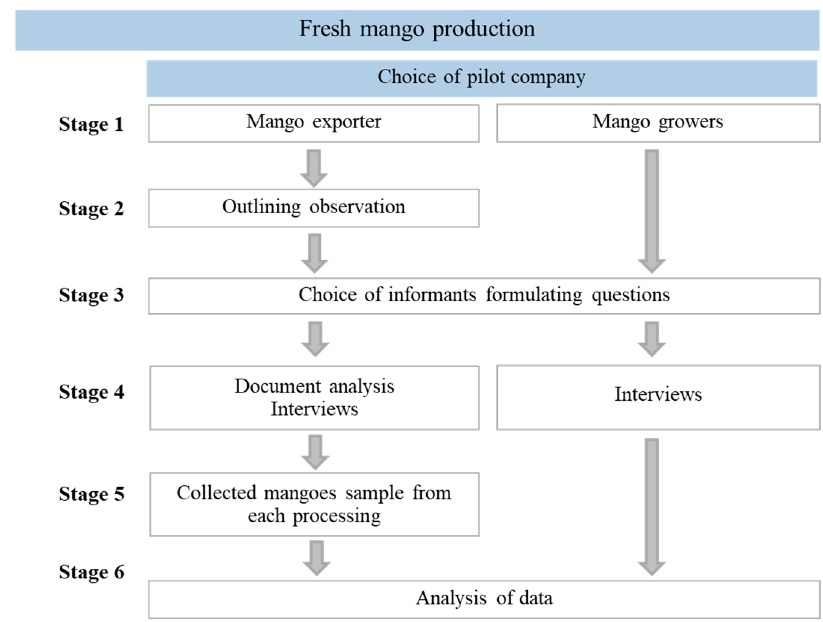
Figure 1 . Overview of steps in the process mapping of the production of ‘Nam Dok Mai’ mango exported to Japan .